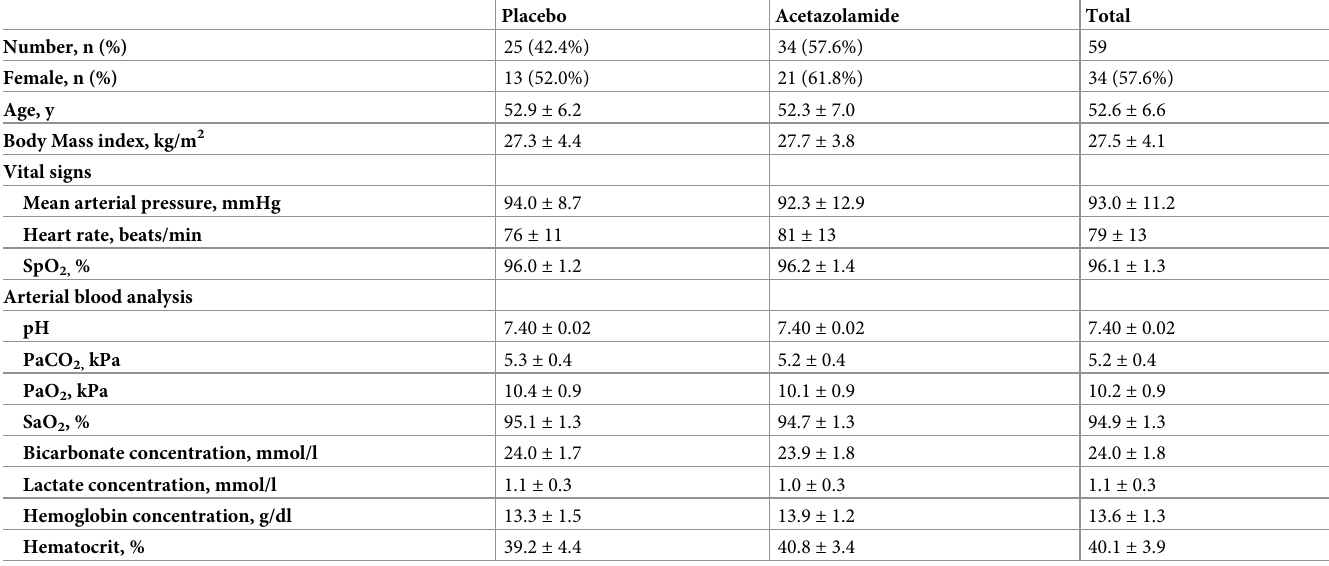
Table 1. Characteristics of participants at baseline